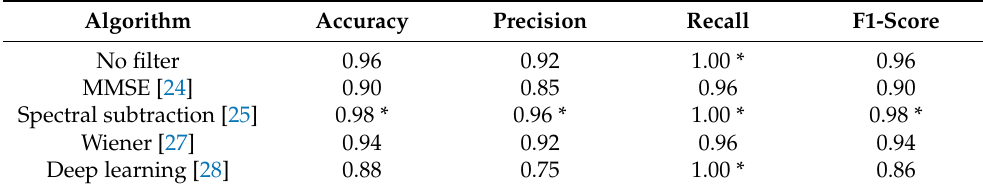
Table 14. Office Noise SNR 5. * is the best result for each particular measure.